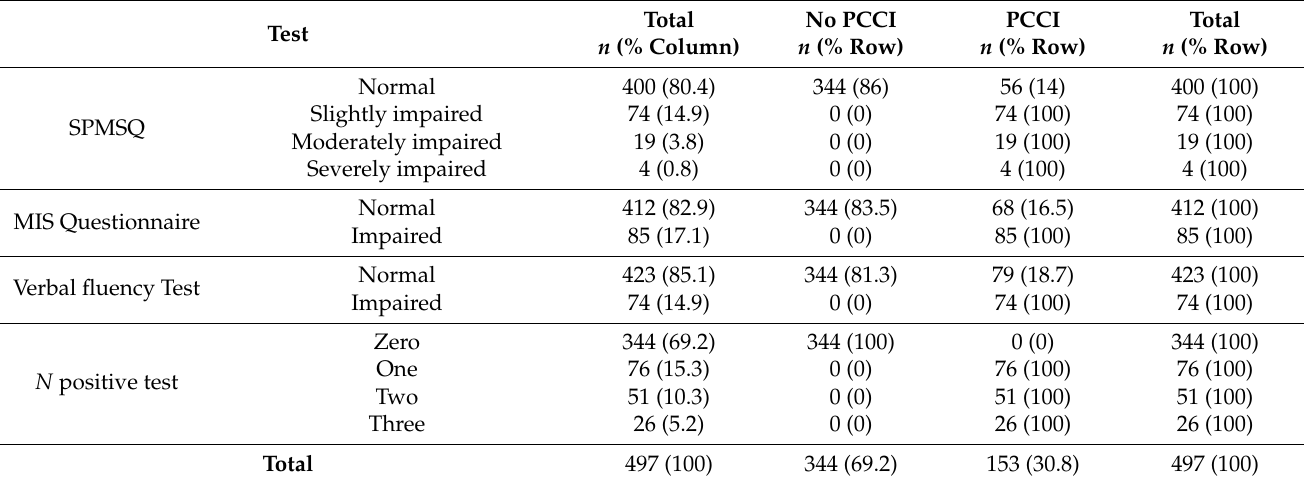
Table 4. Patient classification based on whether the scores on three different screening